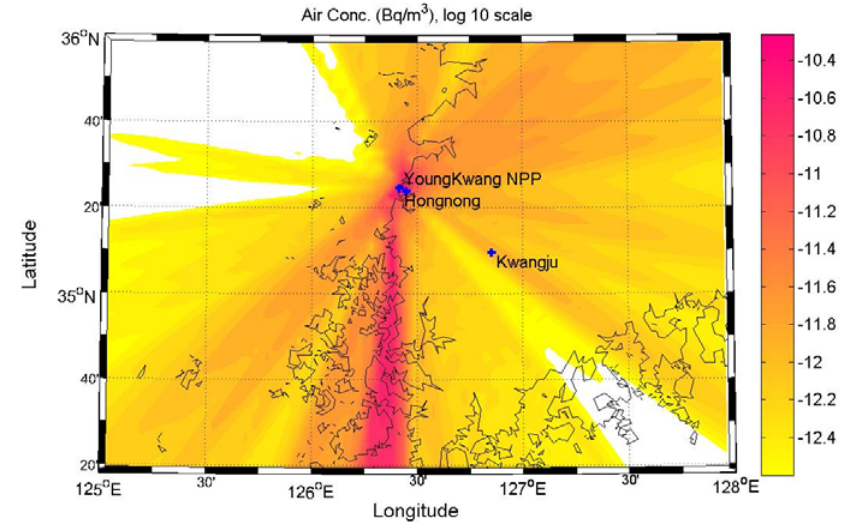
Figure 3. Hourly averaged air concentrations for a radioactive material.